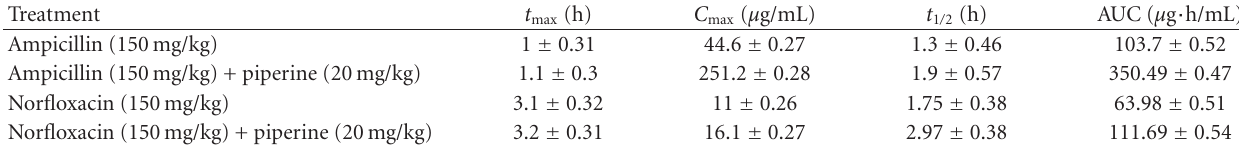
Table 14: Pharmacokinetic parameters of ampicillin, norfloxacin, and in combination with piperine after oral treatment in rabbit [95]. Treatment